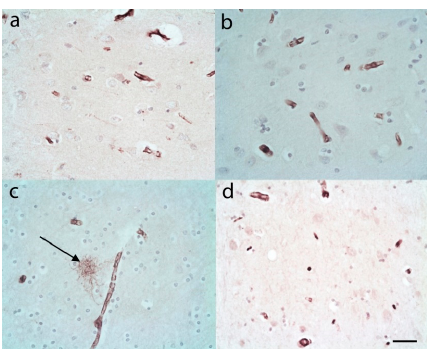
Figure 4. S100A10 immunohistochemistry in control cases revealed positivity in vessel walls but extremely low numbers or no astrocyte-like cells (ASLCs) in the upper frontal cortex ( a ), and the lower frontal cortex ( b ). Only very occasional S100A10 (usually perivascular) immunopositive ASLCs (arrow) were evident in the frontal white matter ( c ). ( d ) The CA4 region of the hippocampus often also revealed no S100A10 immunopositive ASLCs. Anti-S100A10. Original magnifications ( a )–( d ) × 40 (NA 0.9). Scale Bar ( a ), ( b ) − 60 µm, ( c ) − 40 µm, ( d ) − 50 µm.